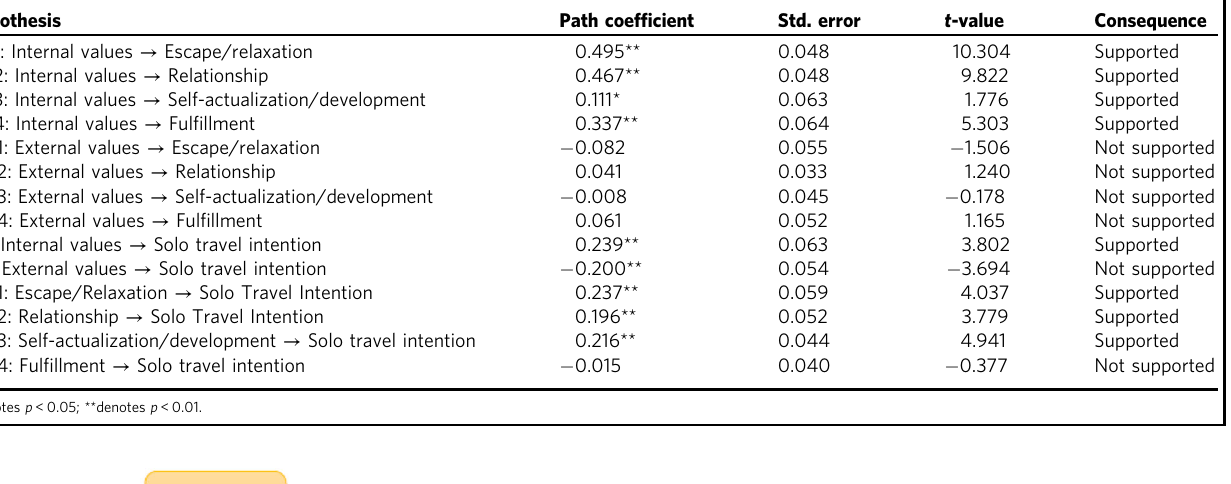
Table 7 Path analysis of structural model.